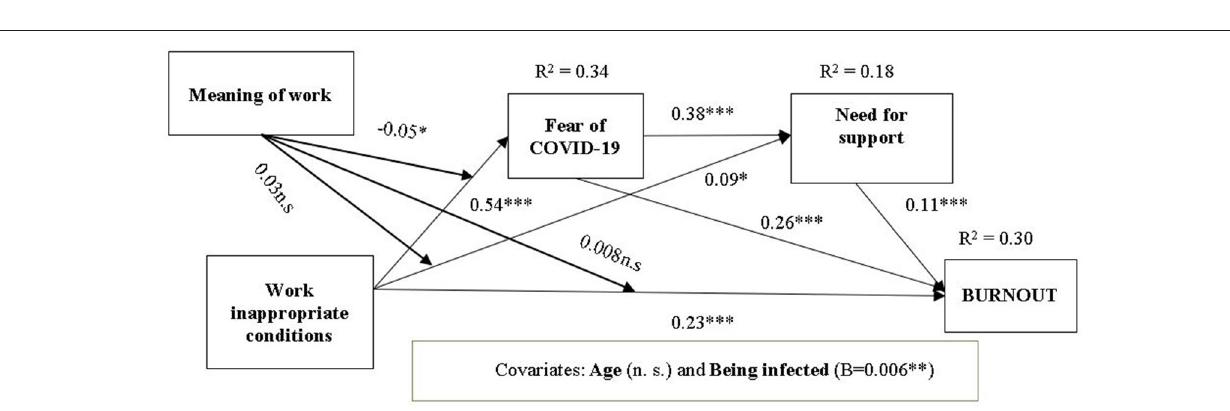
FIGURE 3 | Model 2 moderated serial multiple mediator of relationship between Work conditions and burnout through Fear of COVID-19 consequences and Need for emotional support, moderated by the Meaning of